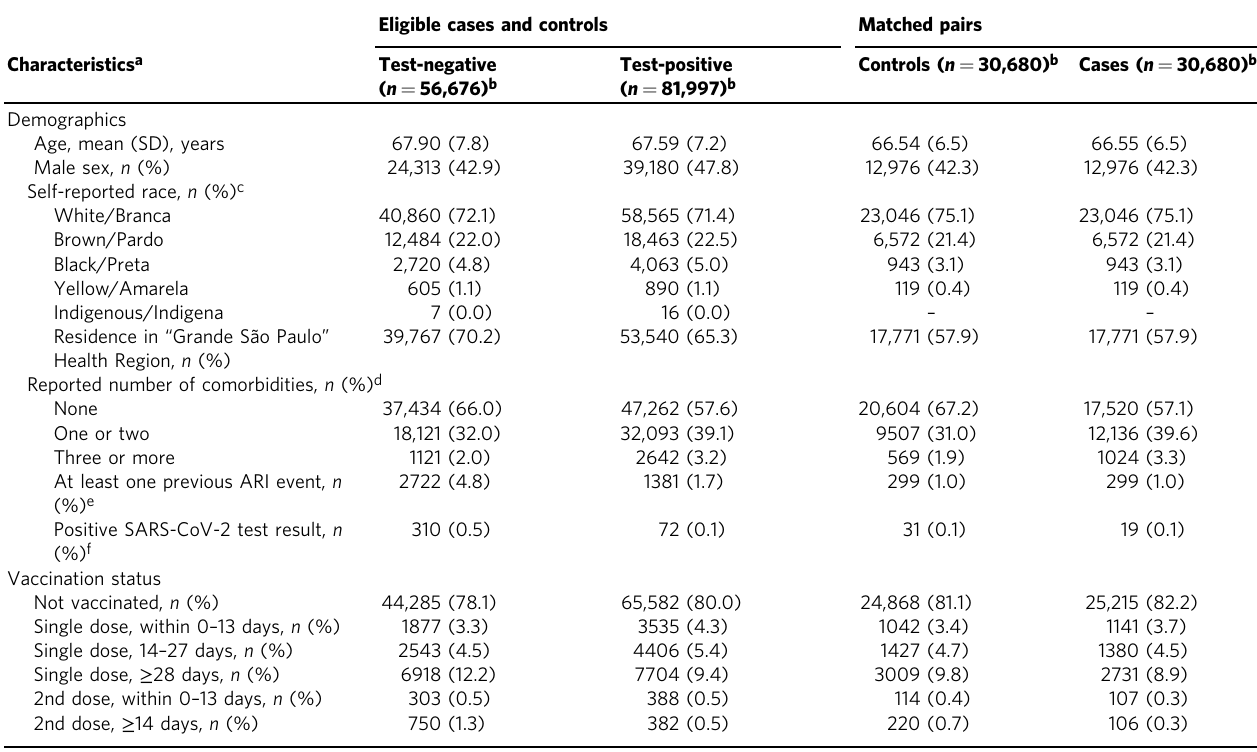
Table 1 Characteristics of adults ≥ 60 years of age who were eligible for matching and selected into case-test negative